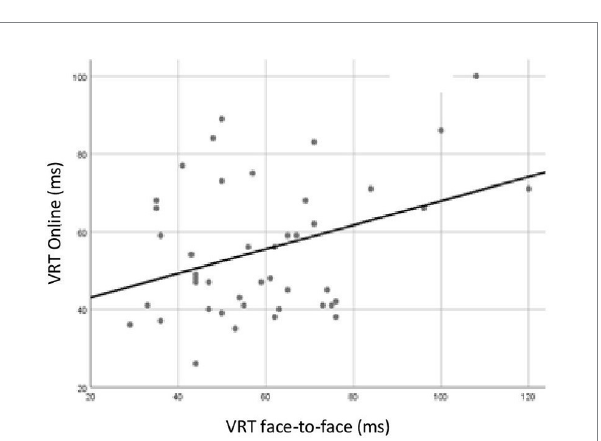
FIGURE 5 Pearson correlation analysis for variability of correct reaction time (VRT) of Brazilians participants tested online and face-to-face. In the horizontal axis, VRT data for participants exposed to face-to face test. In the vertical axis, VRT data for participants exposed to online test. Correlation was statistically significant ( r = 0.36, p = 0.02).